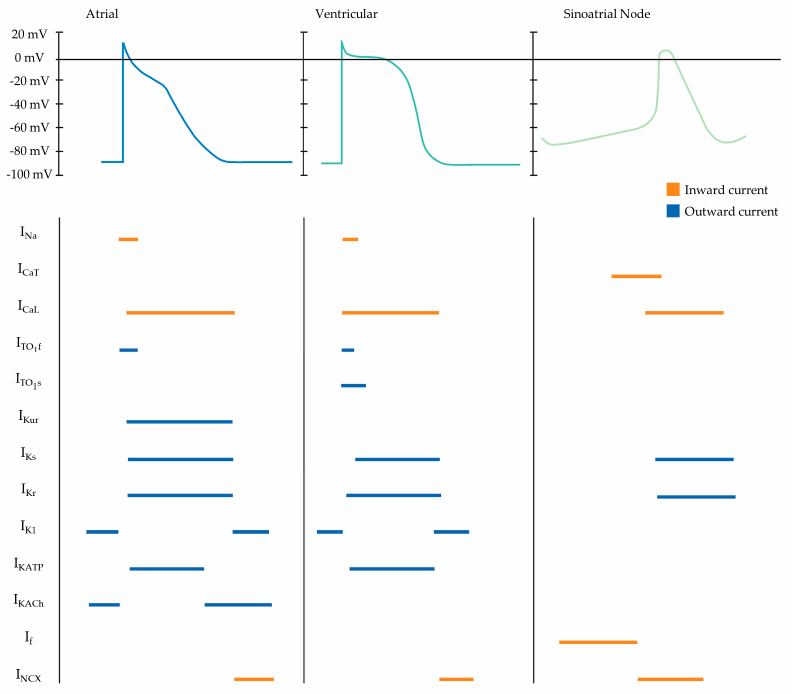
Figure 3. Schematic depicting atrial, ventricular and sinoatrial nodal action potential waveforms and their underlying ionic currents. Horizontal orange and blue lines represent inward and outward cellular currents, respectively. I Na , inward sodium. I CaT , T-type calcium. I CaL , L-type calcium. I to1f , fast transient outward. I to1s , slow transient outward. I Kur , ultra-rapid potassium delayed rectifier. I Ks , slow potassium delayed rectifier. I Kr , rapid potassium delayed rectifier. I K1 , inward rectifier. I KATP , ADP-activated potassium channel. I KACh , muscarinic-gated potassium channel. I f , “funny” current. I NCX , sodium/potassium exchange current.